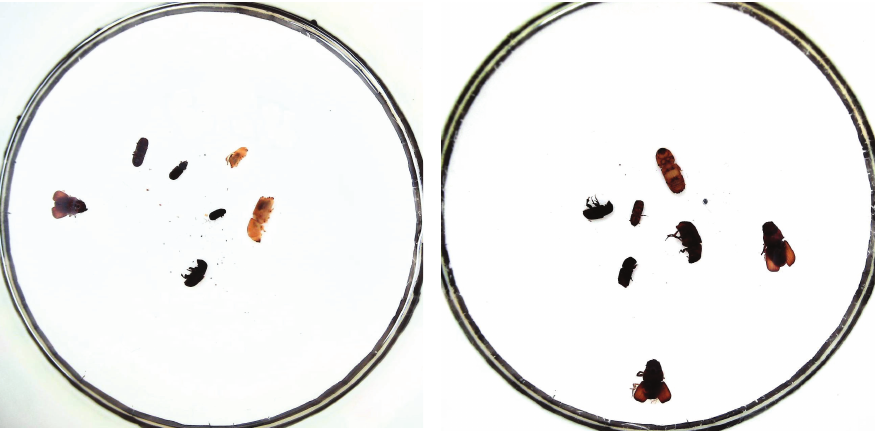
Figure 4. Two images selected from Baidu AI insect detection